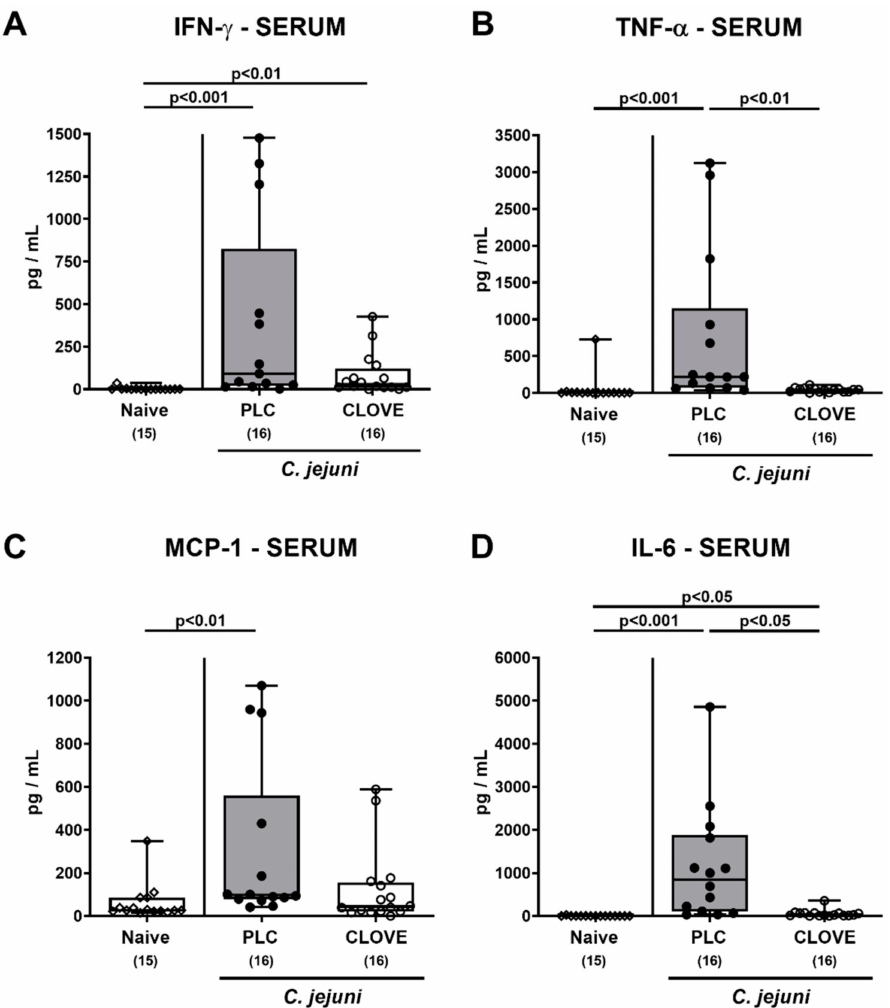
Figure 9. C. jejuni induced systemic proinflammatory mediator secretion following clove EO treat- ment of infected IL-10 − / − mice. Microbiota-depleted IL-10 − / − mice were perorally infected with C. jejuni strain 81-176 on day (d) 0 and d1. From d2 until d6 post-infection (p.i.), mice were perorally challenged with clove EO or received placebo (PLC) via drinking water. On day 6 p.i., ( A ) IFN- γ , ( B ) TNF- α , ( C ) MCP-1 and ( D ) IL-6 concentrations were measured in serum samples. Box plots indicate the 75th and the 25th percentiles of the median (black bar within box). Naive mice were included as negative control animals. The total range, significance levels ( p values) determined by the Kruskal-Wallis test and Dunn’s post-correction and the total numbers of analyzed mice (in parentheses) are given. Definite outliers were removed after being identified by the Grubb’s test ( α = 0.001). Data were pooled from four independent